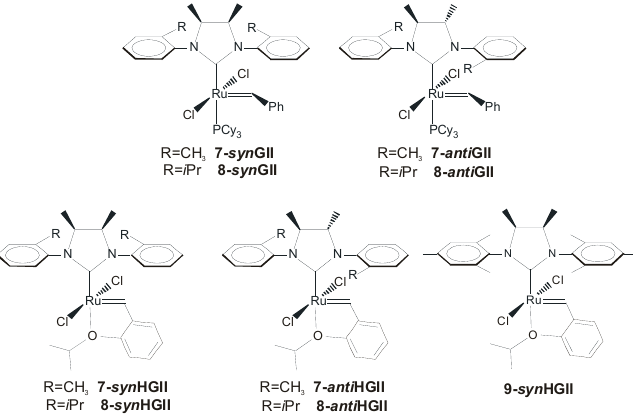
Figure 6. Catalysts with syn and anti methyl groups on the NHC backbone.